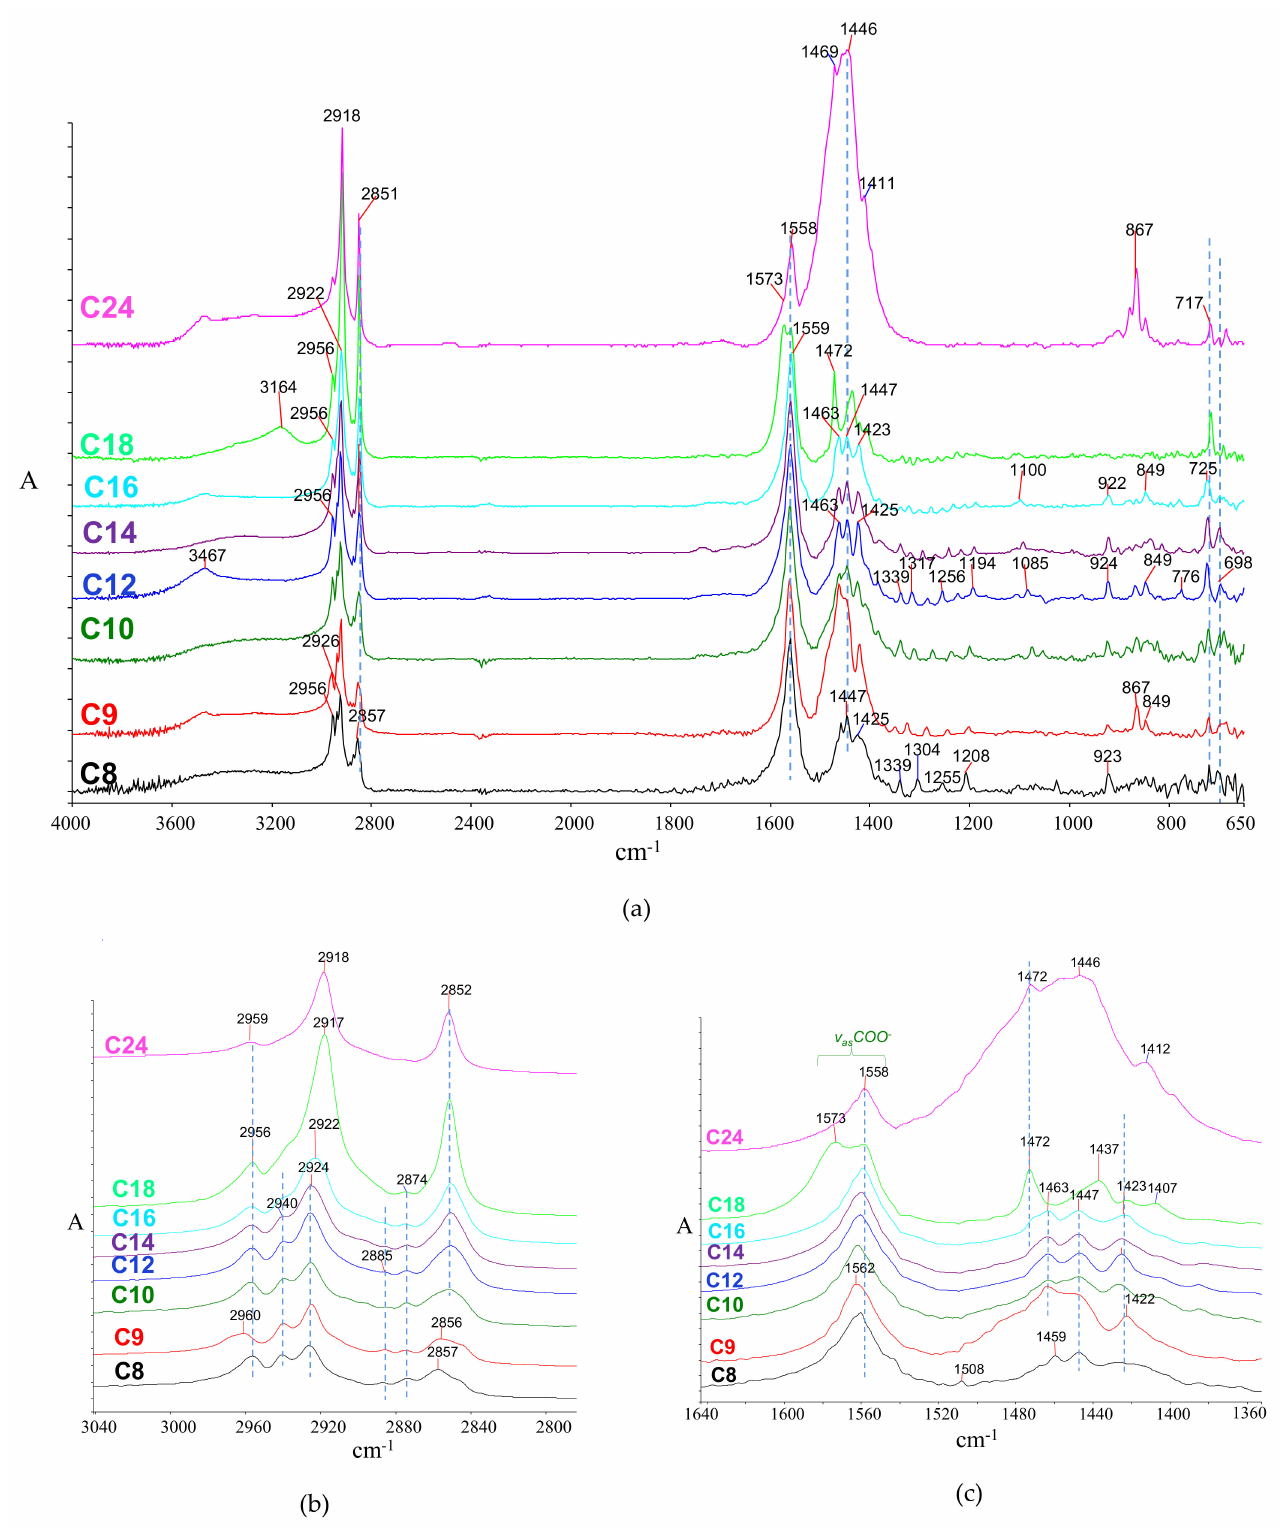
Figure 5. Infrared spectra of fatty acid sodium salts. ( a ) Full spectrum; ( b ) C-H stretching region; and ( c ) carboxylate region. In all spectra: C8, sodium octanoate; C9 sodium nonanoate; C10, sodium decanoate; C12, sodium dodecanoate; C14, sodium tetradecanoate; C16, sodium hexadecanoate; C18, sodium octadecanoate; C24, sodium tetracosanoate; C9 and C24 are contaminated with sodium carbonate (intense peaks at ~1450 and 867 cm − 1 ). The negative peaks at ~2380 cm − 1 correspond to carbon dioxide as a result of improper background